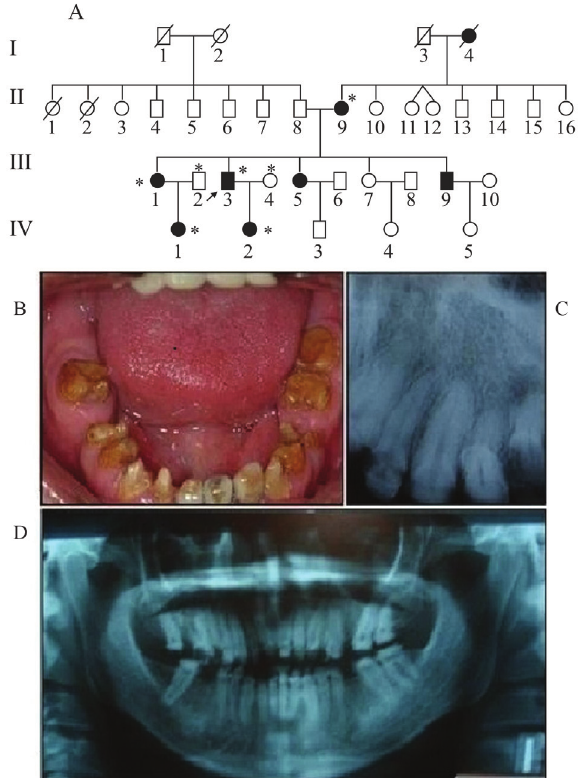
Figure 2 - Family 2. A. The pedigree indicated autosomal dominant inher- itance with two affected members (black symbols). These two cases prob- ably represent de novo mutations since none of the individuals in the first generation were affected. The arrow indicates the proband patient and the asterisks indicate individuals who were analyzed clinically and whose ENAM gene was sequenced. B, C. Photographs of proband III:8. The phe- notype was classified as localized soft hypoplasic and was observed mainly in the anterior teeth. In this patient with mixed dentition, AI was present in deciduous and permanent dentition and was more severe in the latter. D,E. Panorex and periapical radiographs of the same proband show- ing premolars near eruption that were radiolucid in the enamel zone (simi- lar to dentin). The periapical radiograph shows the marked contrast be- tween dentin and enamel in the sixth permanent lower teeth.